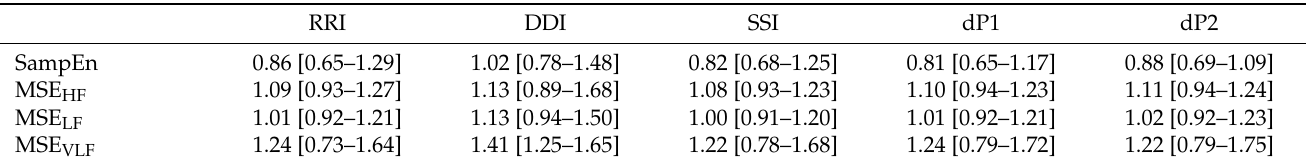
Table A3. Entropy indexes for embedding dimension m = 2 in n = 4 climbers: median [range] of the ratio between measures taken at Camp 2 and